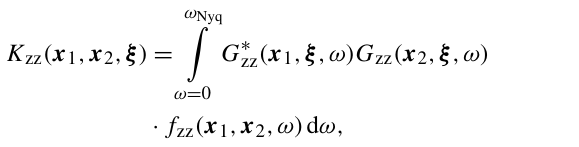
et al. (2011) and stacked. All waveforms in Fig. 4 are nor- malized by maximum